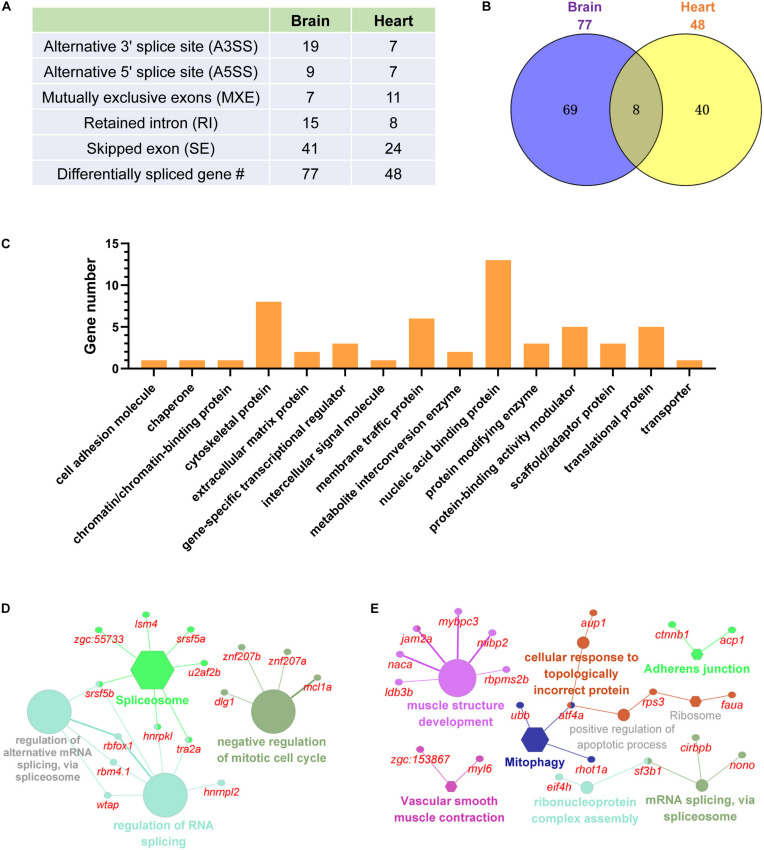
Cold-induced differential splicing of genes in the brain and the heart of common carp. (A) Numbers of different type of alternative splicing events. (B) Common and tissue-specific differentially spliced genes. (C) Classification of the differentially spliced genes according to the PANTHER protein class annotation. (D,E) Functional classification of the differentially spliced genes of the brain (E) and heart (E). The differentially spliced genes and their associated functional terms are shown.